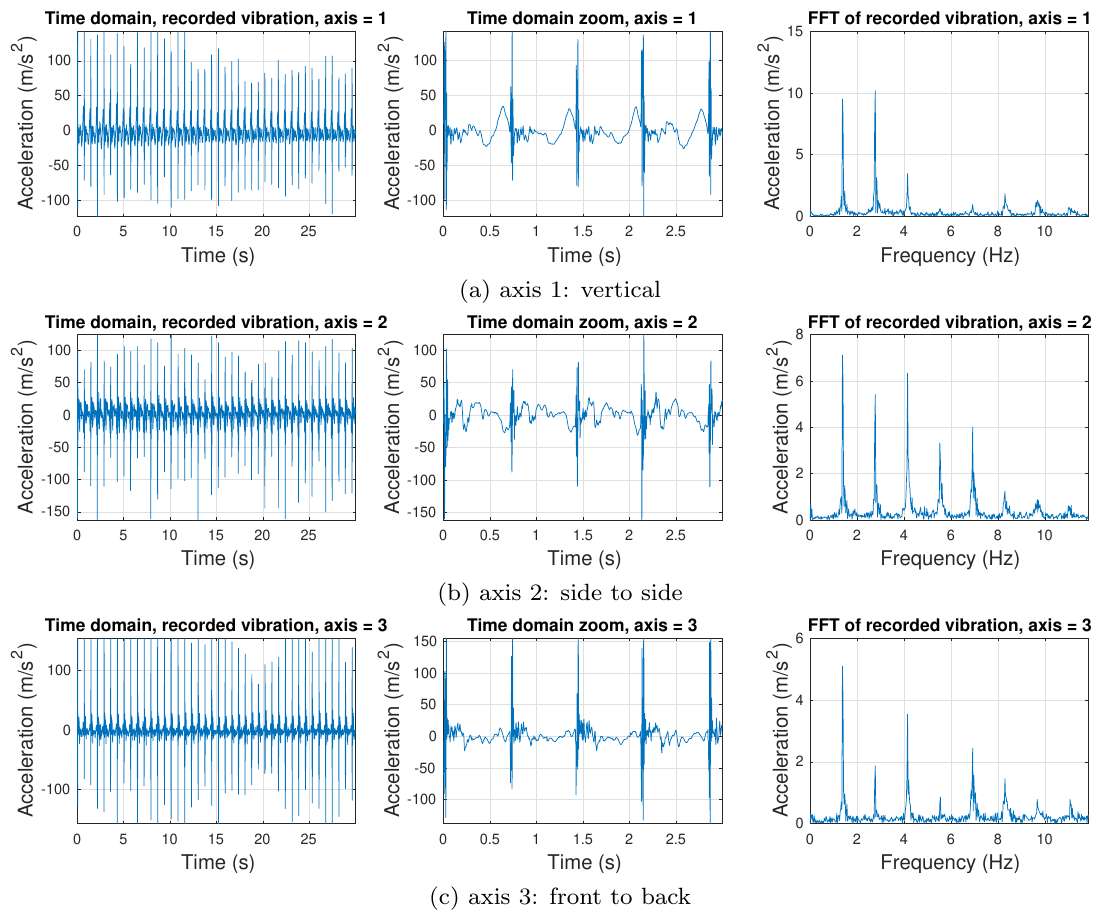
Figure 4: Running at 9 km/h Figure 6. Analysis of gait acceleration in all three axes while running at 9